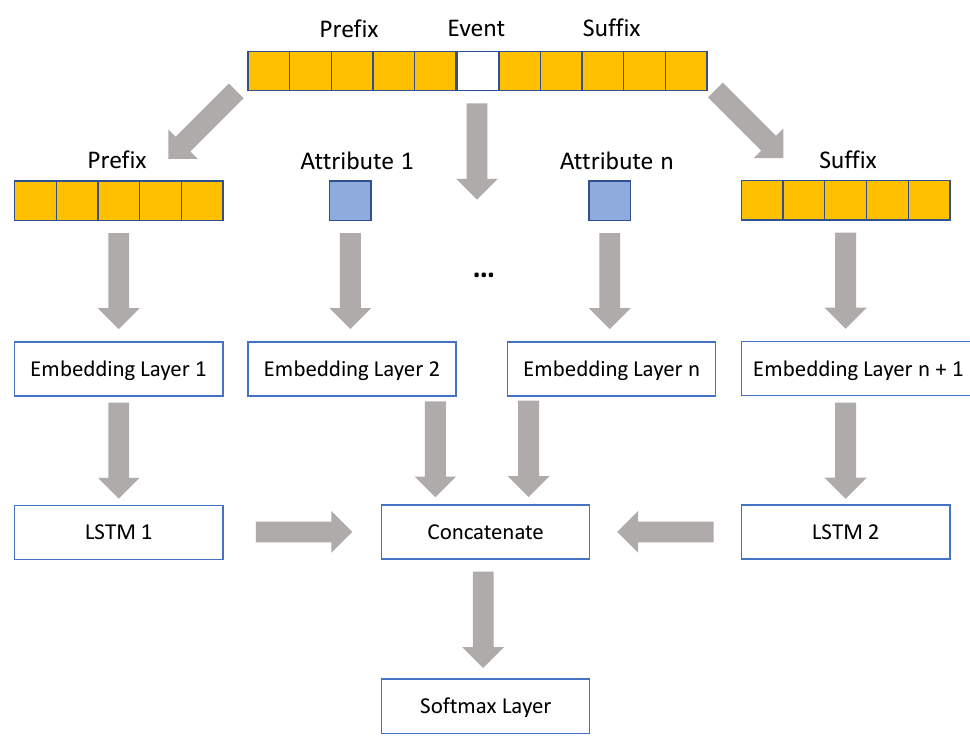
Figure 4. Architecture of our proposed neural network.